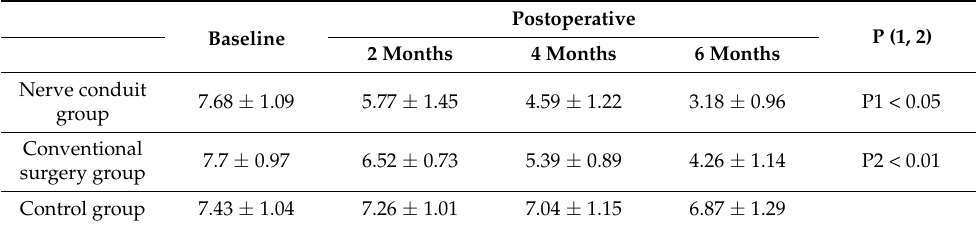
Table 4. Comparison of VAS scores at different time points among the three groups.